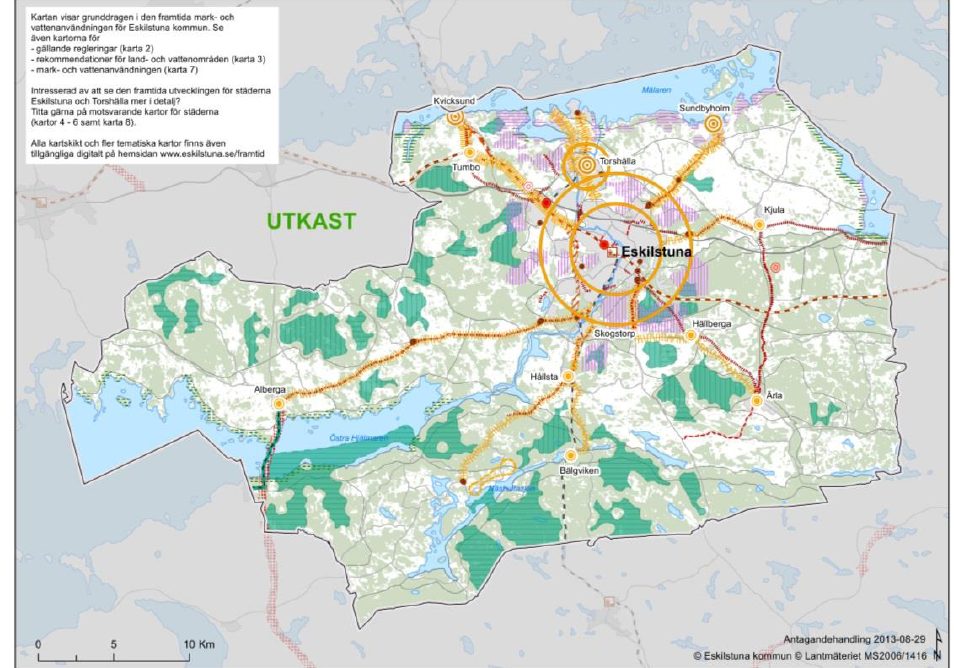
Figure 2. Development concept of Eskilstuna Comprehensive Plan emphasising urban development in the core of Eskils- tuna City and along selected transport axes. Source: Municipality of Eskilstuna,